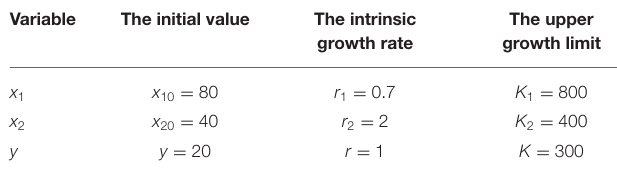
TABLE 2 | Parameter